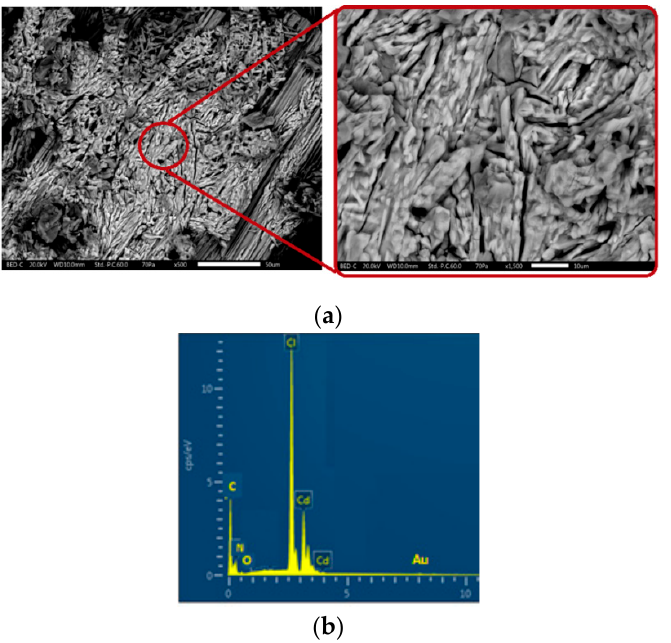
Figure 1. SEM images of (C 6 H 8 Cl 2 N 2 ) 2 [Cd 3 Cl 10 ]·6H 2 O for a magnification 500 times (left) and 1500 times (right) ( a ). EDX spectrum in the zone of high contrast ( b ).